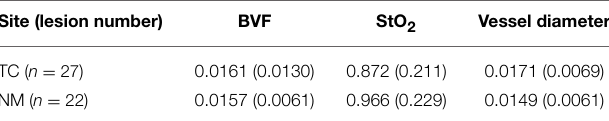
TABLE 1 | Weighted mean (and standard deviation) blood volume fraction (BVF), oxygen saturation (StO2), and D v blood vessel diameter of TC and NM